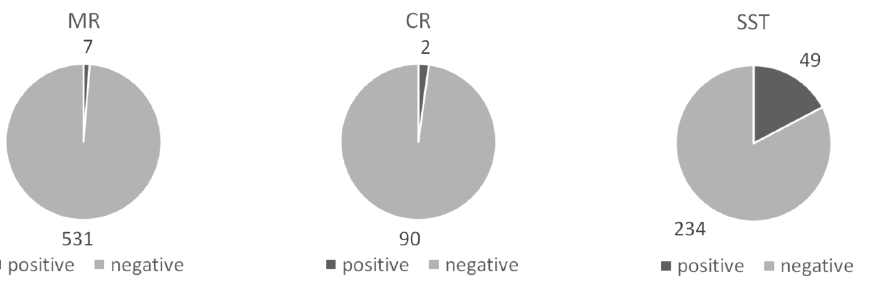
Figure 3. The ratio of positive/negative sentences with weak confidence.